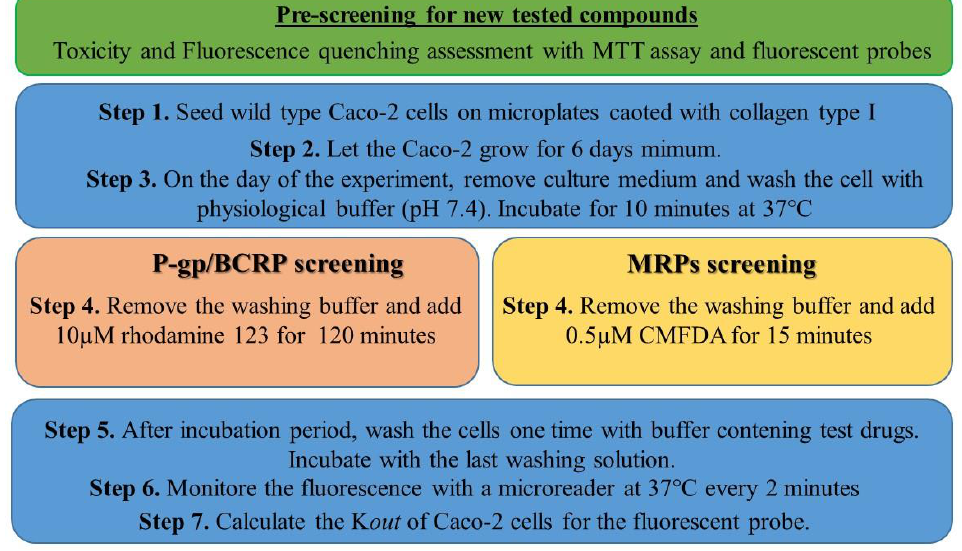
Figure 3. Protocol for the P-gp/BCRP and MRPs microplate screening method.